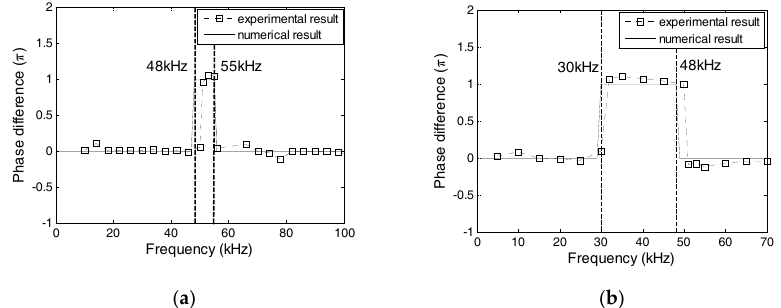
Figure 16. Phase difference between PZT-1 and PZT-2 from Specimens 1 and 2. ( a ) Specimen 1; ( b ) Specimen 2.